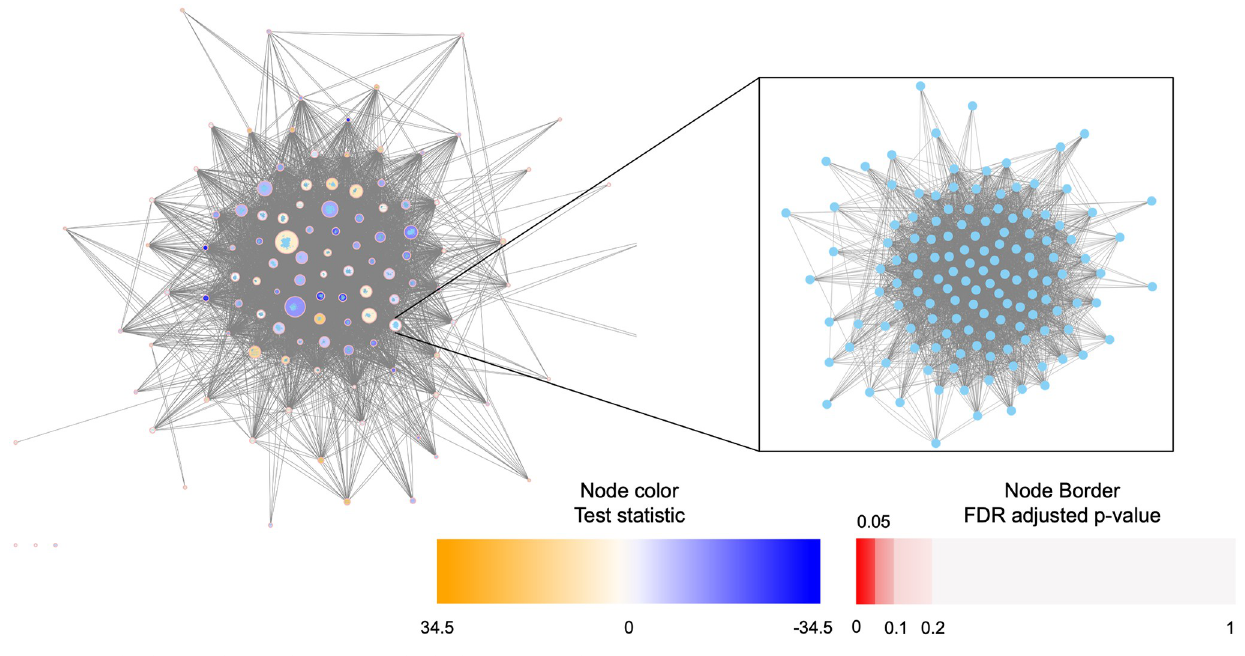
Fig 3. Example of a nested network Cytoscape plot for breast cancer